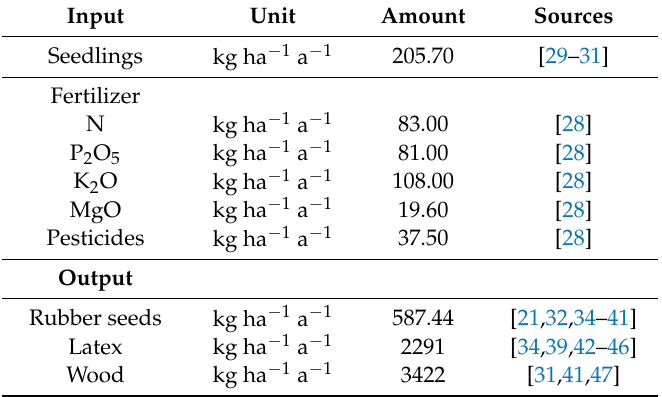
Table 1. Inputs and outputs of a rubber tree plantation cycle.